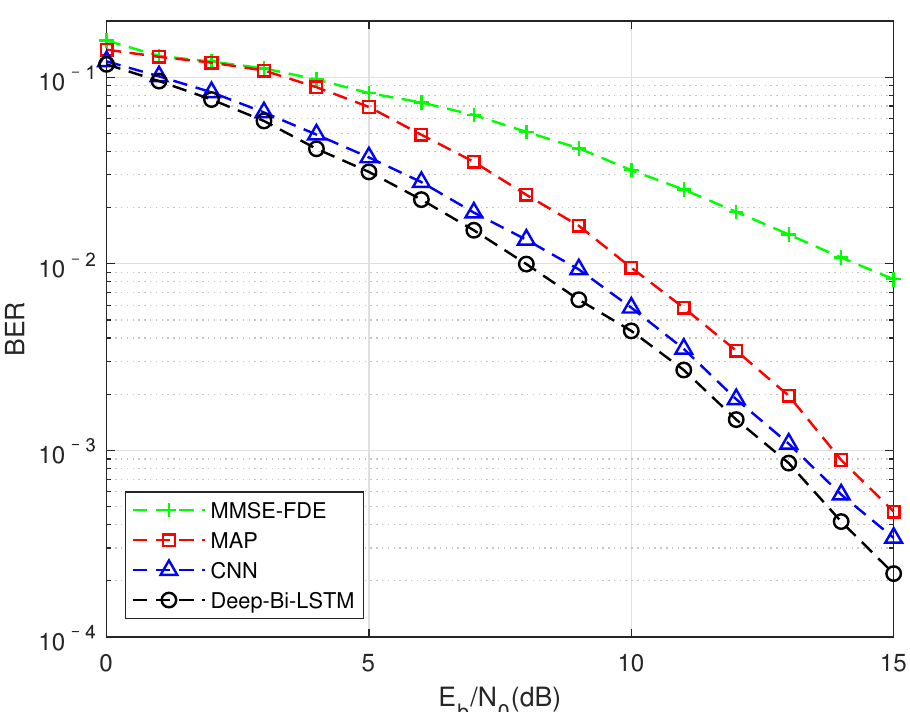
Figure 6. FTN detection performance results of different algorithm in the VA channel, MMSE equalization, and the compression factor τ = 0.7.